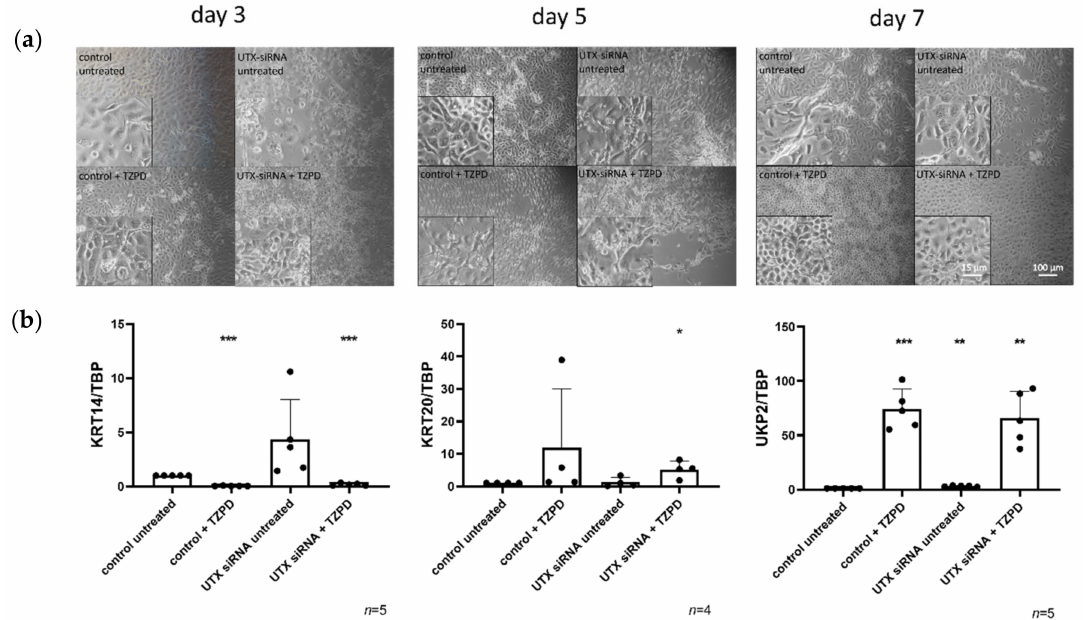
Figure 1. UTX knockdown in primary urothelial cells (UECs) causes delays, but does not block induction of di ff erentiation by TZ / PD. ( a ) Morphology of UECs treated with control siRNA or UTX-siRNA 01 after 3, 5 and 7 days. Note changes in cell morphology and viability following treatment with UTX-siRNA in cells not treated with TZ / PD and a slight retardation of morphological di ff erentiation over the first five days compared to cells treated with the control siRNA. ( b ) Expression of KRT14, KRT20 and UPK2 on day 10 after induction of di ff erentiation. Note the lack of significant di ff erences in the three markers in di ff erentiated cells, but the upregulation of KRT14 mRNA following UTX knockdown in cells not treated with TZ / PD. Number of analyzed independent cultures, n = 4 or 5. Statistics were performed with a one sample t test against the set value of 1 for the untreated control (* p < 0.05; ** p < 0.01; *** p < 0.001). Scale 15 µ m or 100 µ